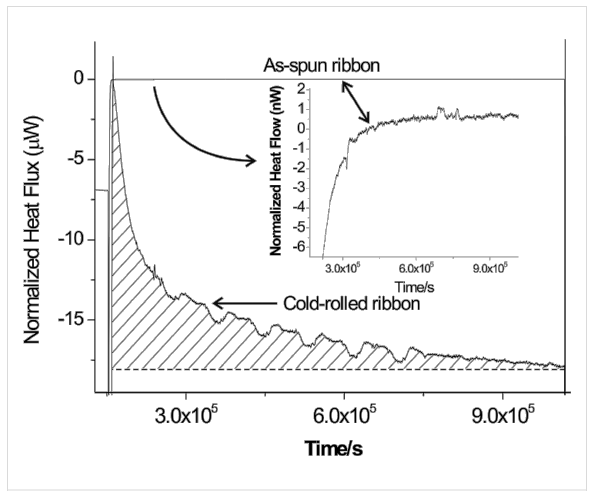
Figure 1: Isothermal microcalorimeter trace at 60 °C for as-spun and cold-rolled ribbons. The inset shows the trace of the as-spun ribbon at a scale of